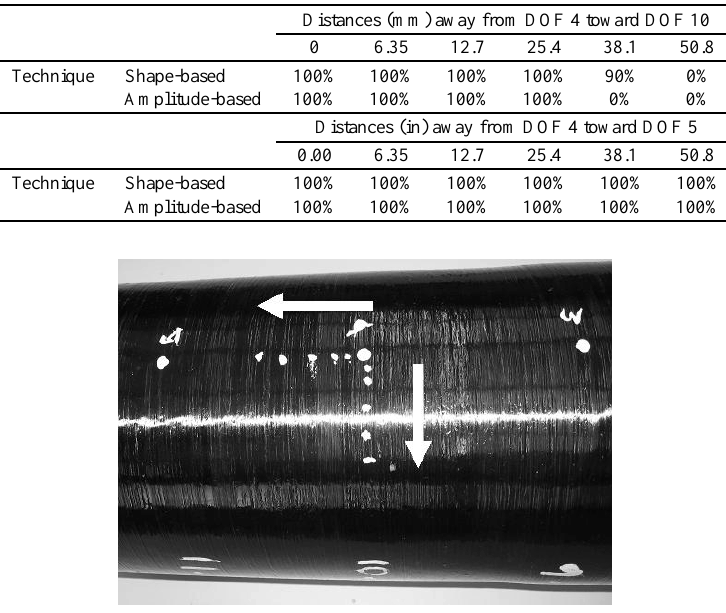
Fig. 17. The impact location was varied away from the trained input DOF in both the radial and axial directions. the ability of the two force-estimation techniques to correctly identify the nearest input DOF for forces that do not act exactly at one of the 24 possible points. A modal impact hammer with an acrylic tip is used to impulsively impact the RMC at a specified and trained input DOF and at varying distances away from the input DOF. The input force is applied 6.35, 12.7, 25.4, 38.1, and 50.8 millimeters away from the input DOF in both the circumferential and axial directions as shown in Fig.